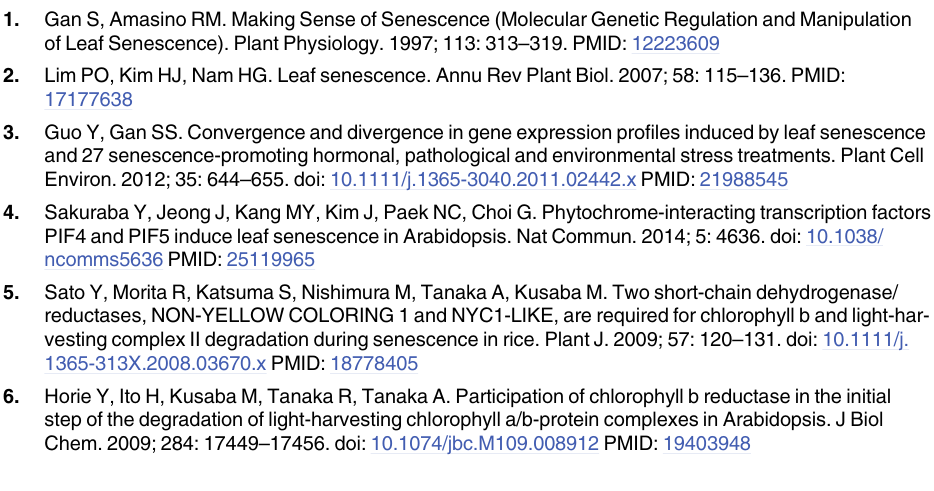
S6 Fig. ORE1 promotes ACS2 expression. qRT-PCR analysis of the ACS2 transcript levels in third and fourth leaves of 4-week-old WT, nac2-1 , and ORE1ox with 100 μ L/L ethylene treat- ment for 4 d. The ACS2 transcript level in WT was arbitrarily set to 1. Data are mean ± SEM from 2 biological replicates (one-way ANOVA). Levels not connected by same letter are signifi- cantly different. p < 0.01. (TIF) S7 Fig. The phenotypes and chl contents of nyc1 and pao mutants with ethylene treatment. (A) Detached third and fourth rosette leaves from 4-week-old WT, nyc1 , and pao plants treated with 100 μ L/L ethylene for 3 d. (B) Quantitative analysis of total chl content in leaves of each genotype shown in (A). Data are mean ± SEM (n = 3). (cid:1) p < 0.05 ( t -test). (TIF) S1 Table. Primers used in the study.